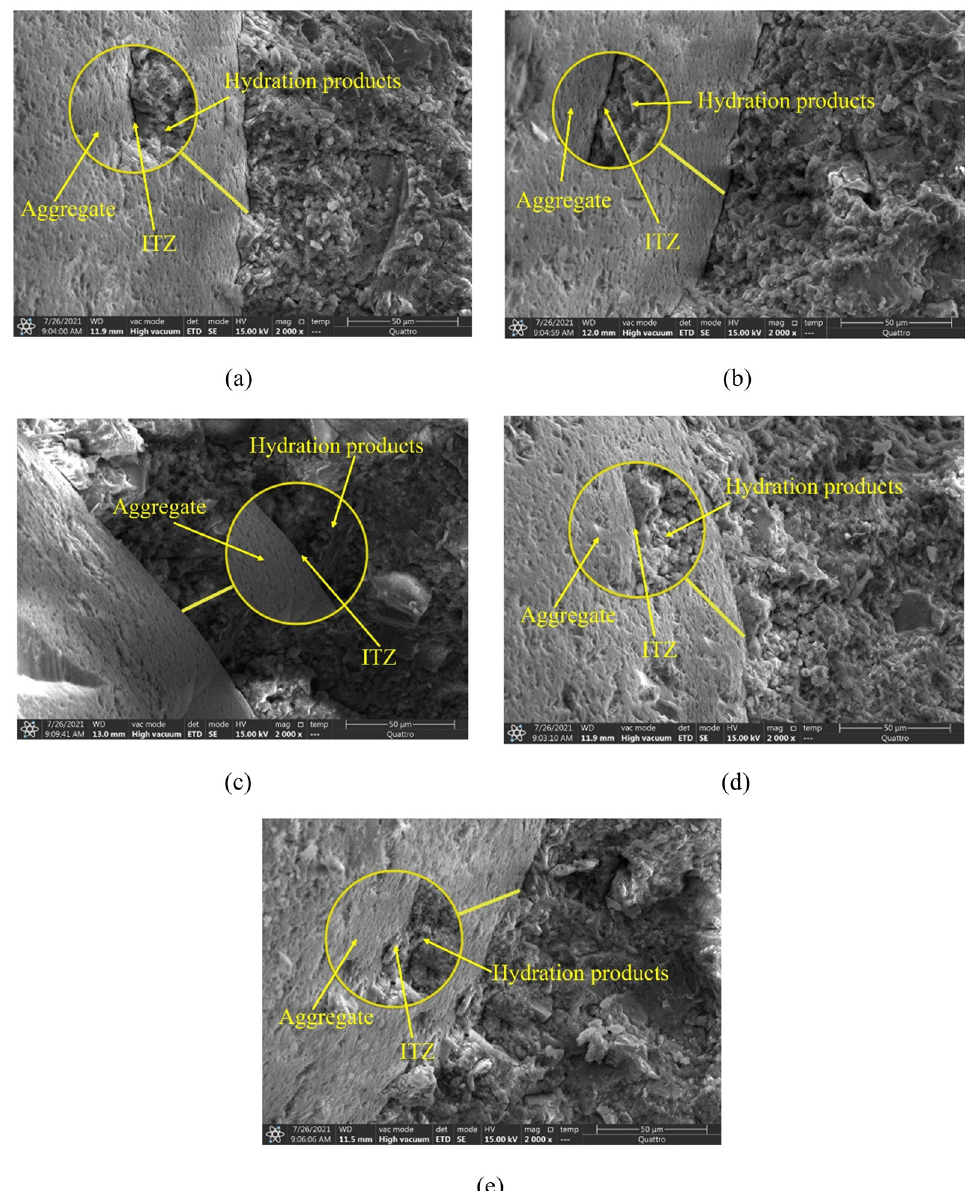
Figure 7: Micromorphology of the matrix after curing for 28 days: ( a ) N0, ( b ) N2, ( c ) N5, ( d ) N6, and ( e )